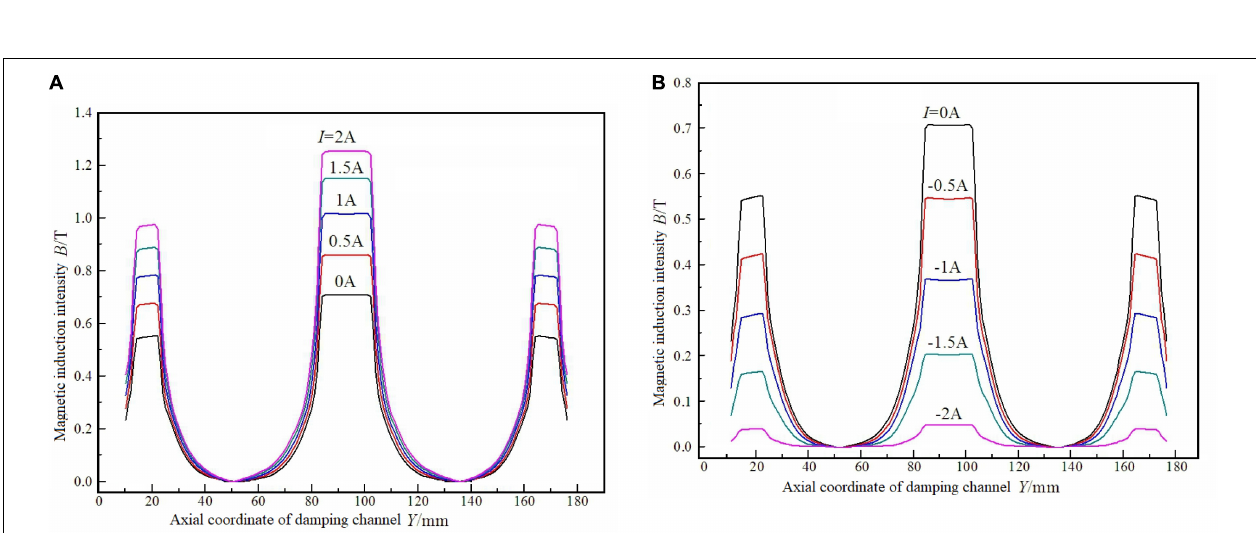
Frontiers in Materials |